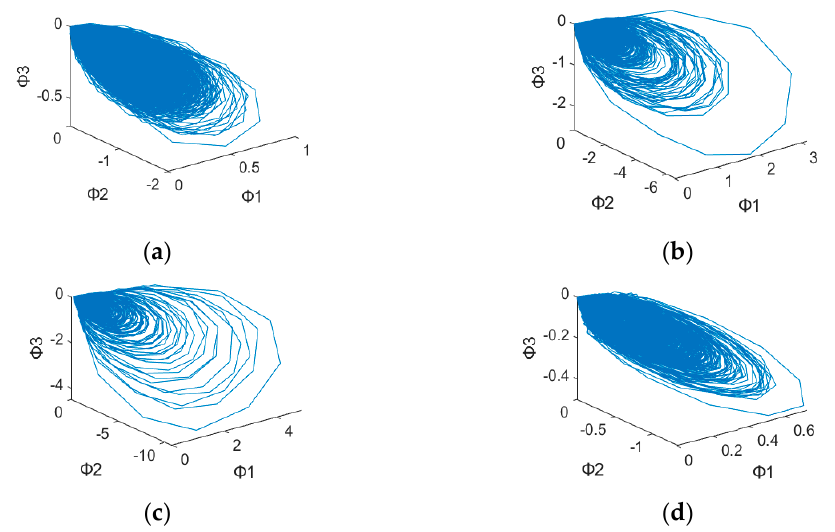
Figure 8. 3D dynamic error phase diagram of ball bearing under testing, with α = 0.6, HP = 0, and SPOF diameter = 0.014 in. ( a ) Normal state. ( b ) Ball fault. ( c ) Inner race fault. ( d ) Outer race fault. Table 3. 3D Dynamic Error Phase Diagram of Ball Bearing Under Testing.